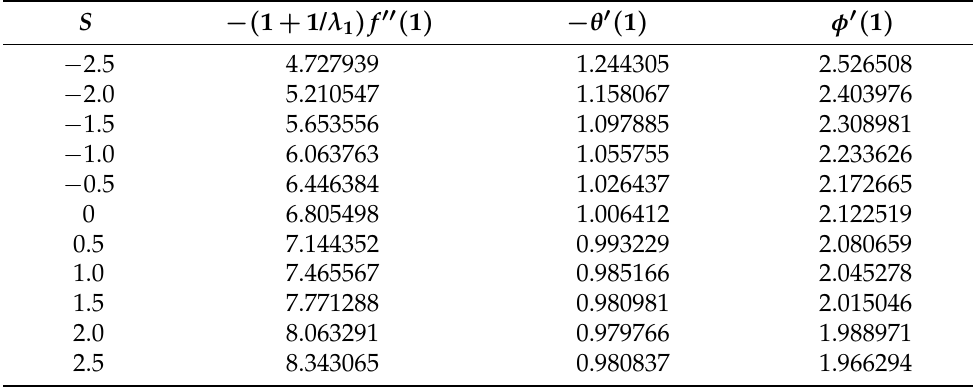
Table 4. Numerical results of − ( 1 + 1/ λ 1 ) f (cid:48)(cid:48) ( 1 ) , − θ (cid:48) ( 1 ) and φ (cid:48) ( 1 ) for S when De = γ =